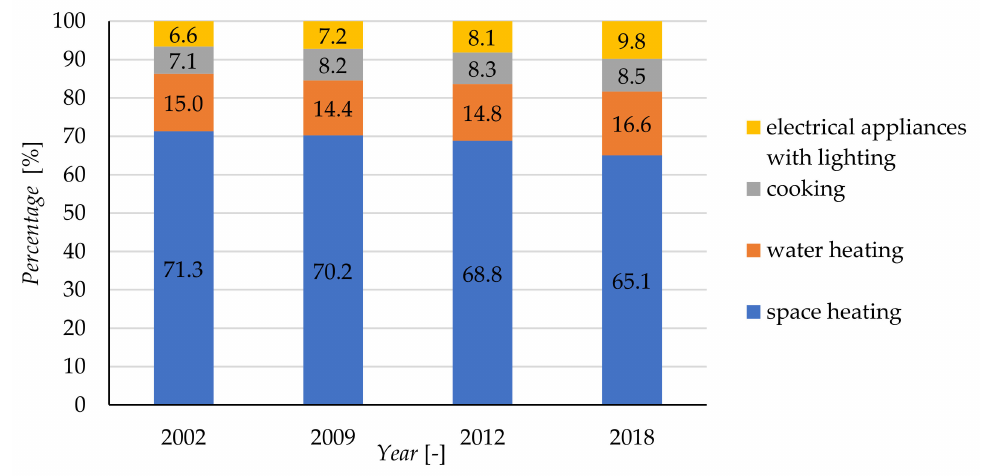
Figure 1. Structure of energy consumption in households in Poland